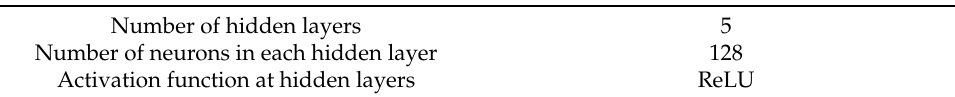
Table 4. Structure of the